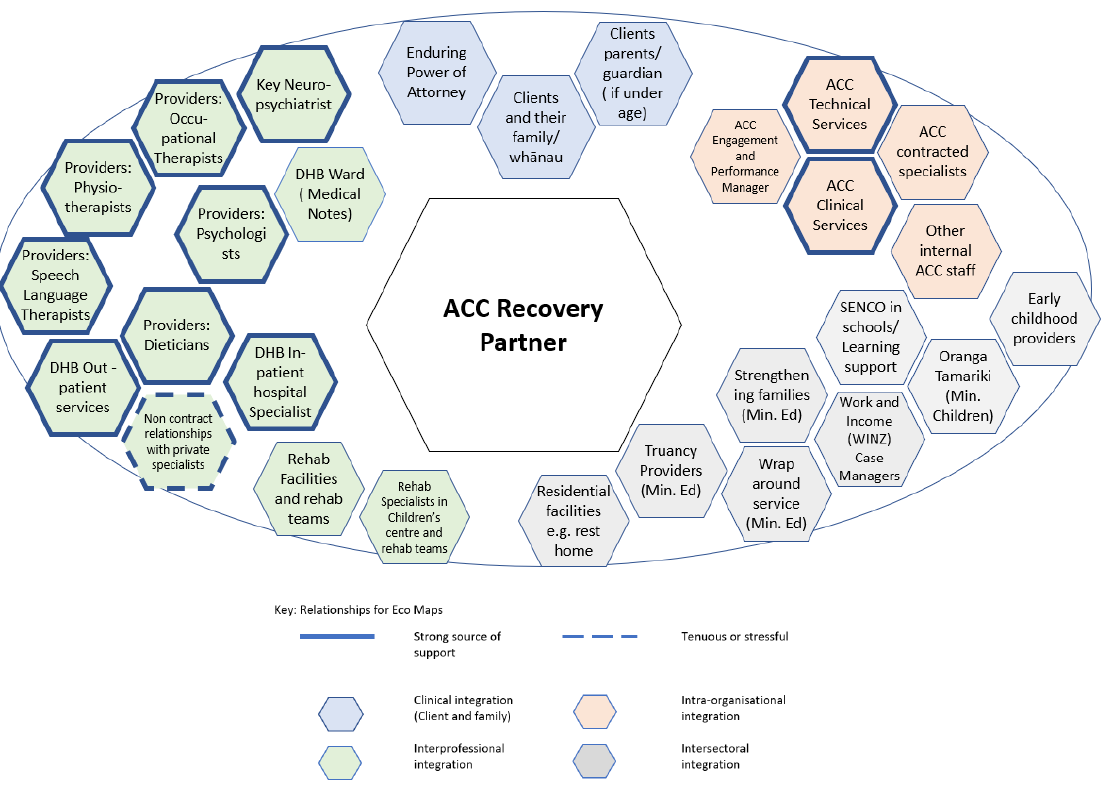
Figure 3. Example of ecomap for ACC Recovery Partner who focuses on child and adolescent